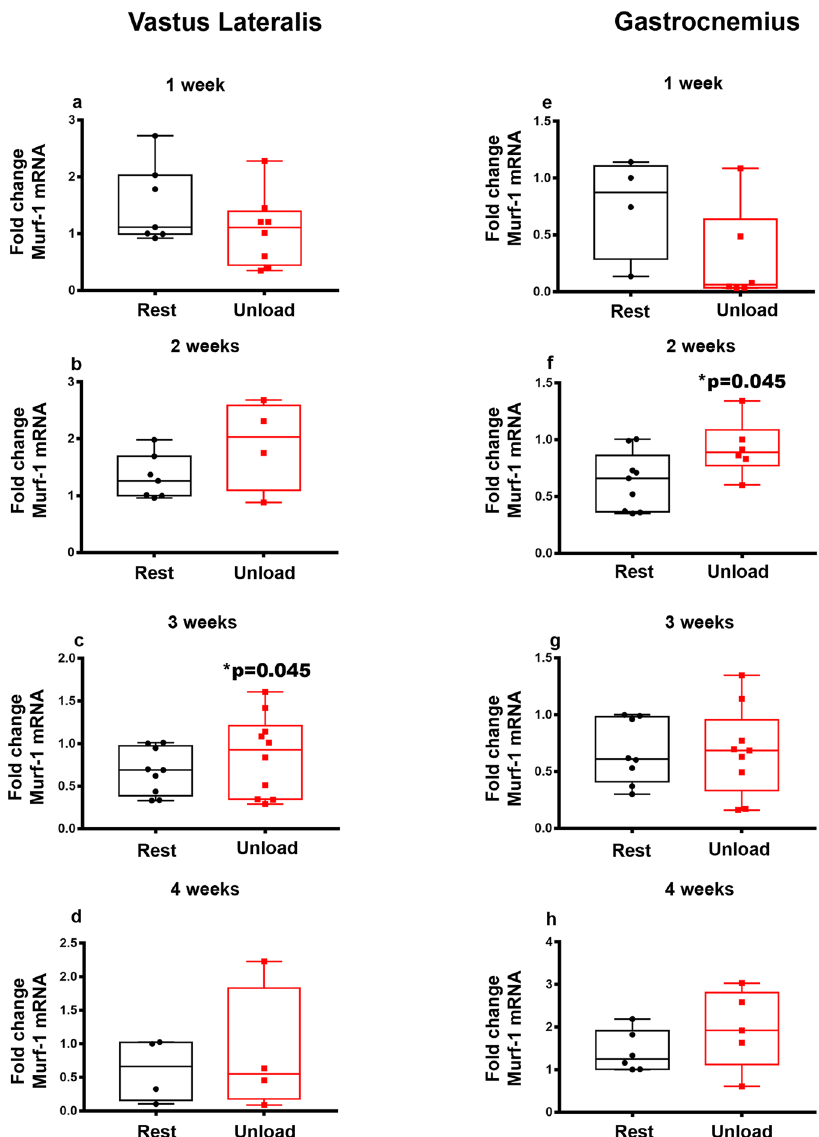
Fig. 2 Effect of unloading on Murf-1 mRNA expression in Vastus Lateralis and Gastrocnemius. Quantitative PCR (qPCR) showing mRNA expression levels of Murf-1 in Vastus Lateralis ( a – d ), and Gastrocnemius ( e – h ) muscles of control mice kept in resting condition (Rest) and HU mice (Unload) at time points 1-2-3 and 4 weeks. The results showed a signi fi cant increase in Murf-1 expression at 3 weeks in Vastus Lateralis ( c ) and 2 weeks in Gastrocnemius ( f ) muscles. Shapiro-Wilk test and Mann-Whitney test were performed. Data are presented as box-and-whisker with median and interquartile ranges, from max to min, with all data points shown. * p < 0.05 vs